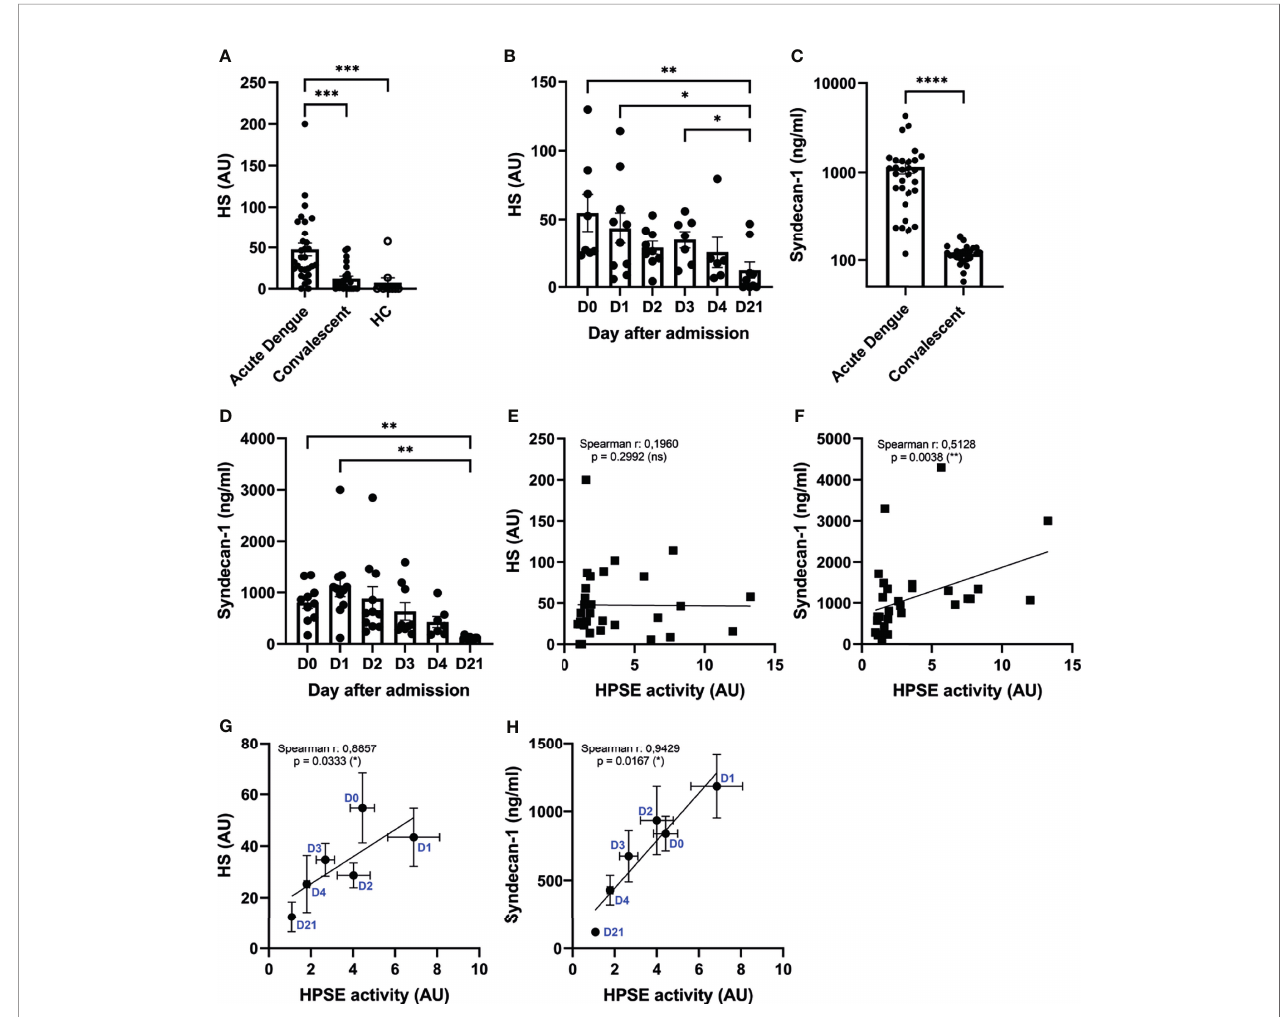
FIGURE 3 | Increased HPSE activity is associated with elevated endothelial glycocalyx degradation markers. (A) HS plasma levels in acute dengue (n=30), convalescent dengue (n=25), and healthy controls (n=10). (B) HS plasma levels in acute dengue patients over time (n=10). (C) Syndecan-1 plasma levels in acute dengue (n=30) and convalescent dengue (n=25). (D) Syndecan-1 plasma levels in acute dengue patients over time (n=11). (E) Correlation between HPSE activity and HS plasma levels of acute dengue patients at day 1 upon hospitalization (n=30). (F) Correlation between HPSE activity and syndecan-1 plasma levels (n=30) in acute dengue patients at day 1 upon hospitalization (n=30). (G) Correlation between HPSE activity and HS plasma levels of acute dengue patients over time (n=10). For each time point the mean and SEM HPSE activity/HS levels of all patients measured at that time point is depicted. (H) Correlation between HPSE activity and syndecan-1 plasma levels (n=10) in acute dengue patients over time. For each time point the mean and SEM HPSE activity/syndecan-1 levels of all patients measured at that time point is depicted. Data were presented as mean ± SEM and tested for normal distribution with D ’ Agostino & Pearson omnibus normality test. Statistical differences were calculated using Mann-Whitney U, mixed-model analysis followed by Bonferroni multiple comparison test, Kruskal-Wallis test followed by Dunn ’ s multiple comparisons test. Correlation analysis was performed with Spearman ’ s correlation coëf fi cient (*p < 0.05, **p < 0.01, ***p < 0.001, ****p < 0.0001). HPSE, heparanase; HS, heparan sulfate; AU, arbitrary units; HC, healthy control; D,